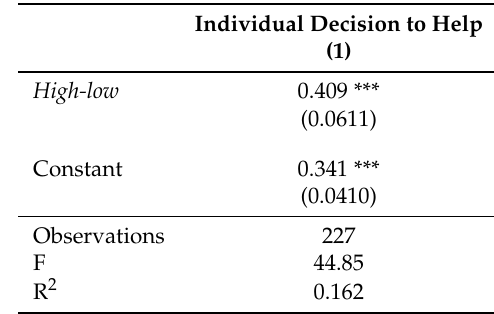
Table A8. Linear regressions: Part B helping in low-low and high-low groups of subjects who only sometimes help in Part A.